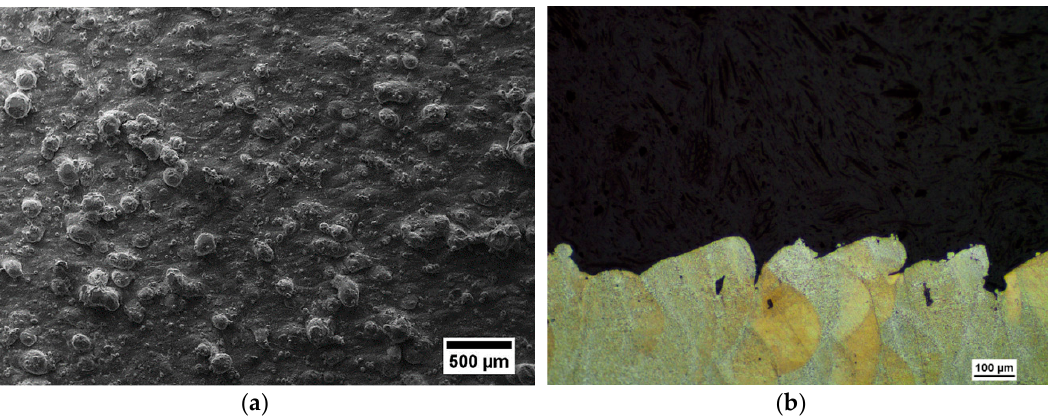
Figure 3. Surface morphology of the as-built AlSi10Mg specimens. ( a ) SEM view of side surface; ( b ) optical micrograph of a cross-sectioned sample showing a view of surface profile; the build direction (z-axis) is horizontal.